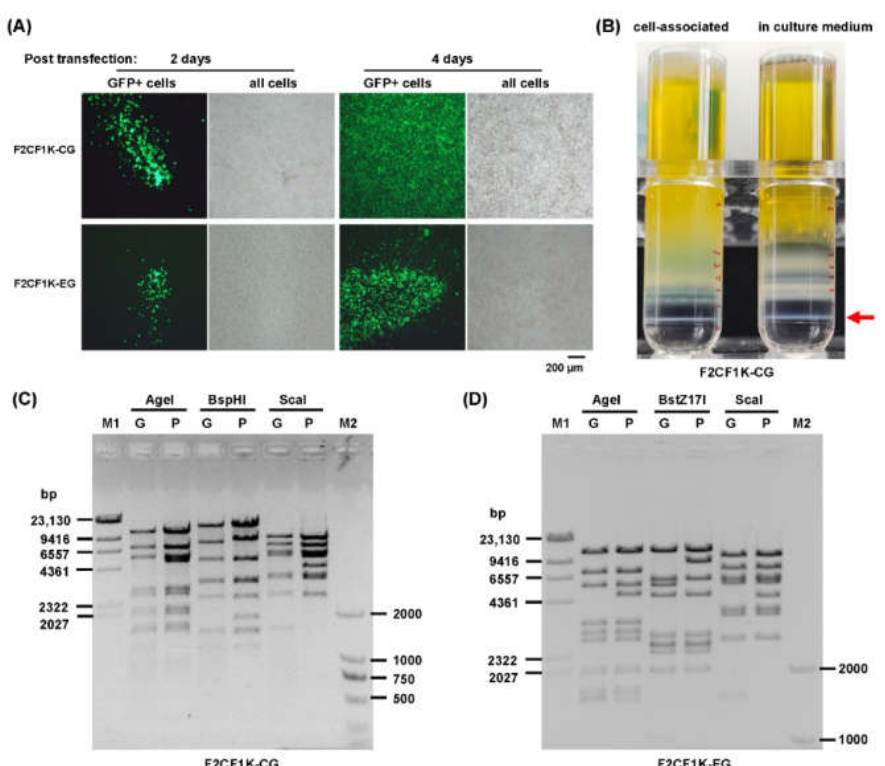
Figure 2. Rescue, purification and identification of fiber-modified FAdV-4 vectors. ( A ) Rescue of FAdV4-F2CF1K-CG and FAdV4-F2CF1K-EG virus. PmeI-linearized pKFAV4S-F2CF1K-CG or pKFAV4S-F2CF1K-EG were used to transfected LMH cells. Foci formed by GFP-positive cells were